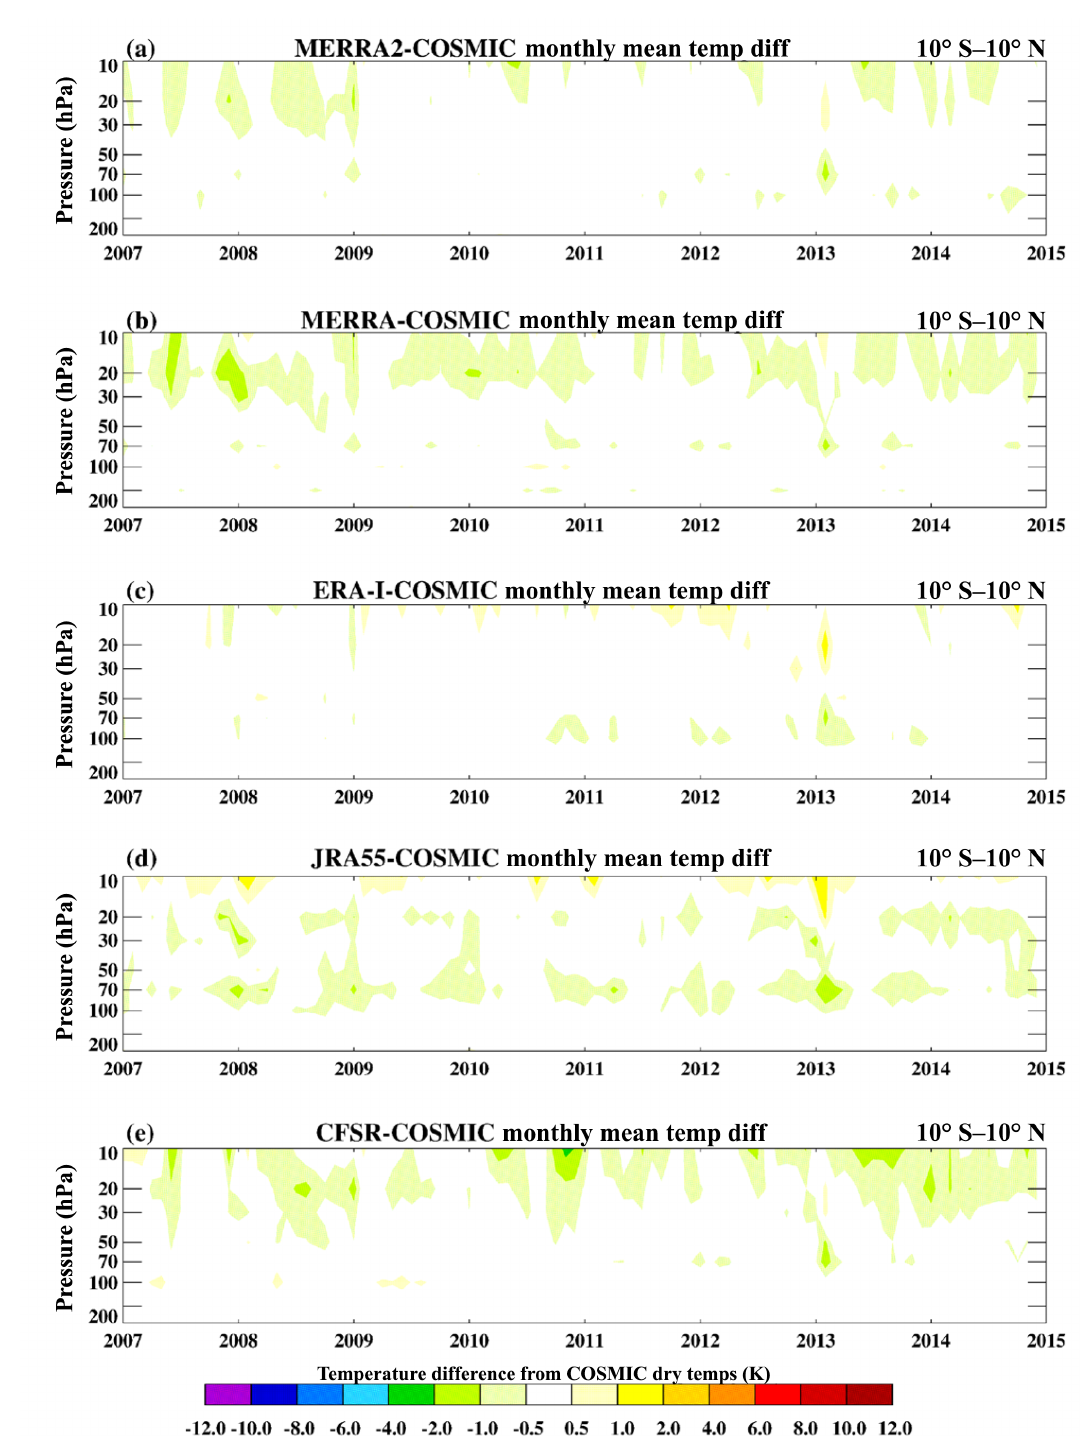
Figure 17. Same as Fig. 15 except for the equatorial-latitude zone (10 ◦ S–10 ◦ N).